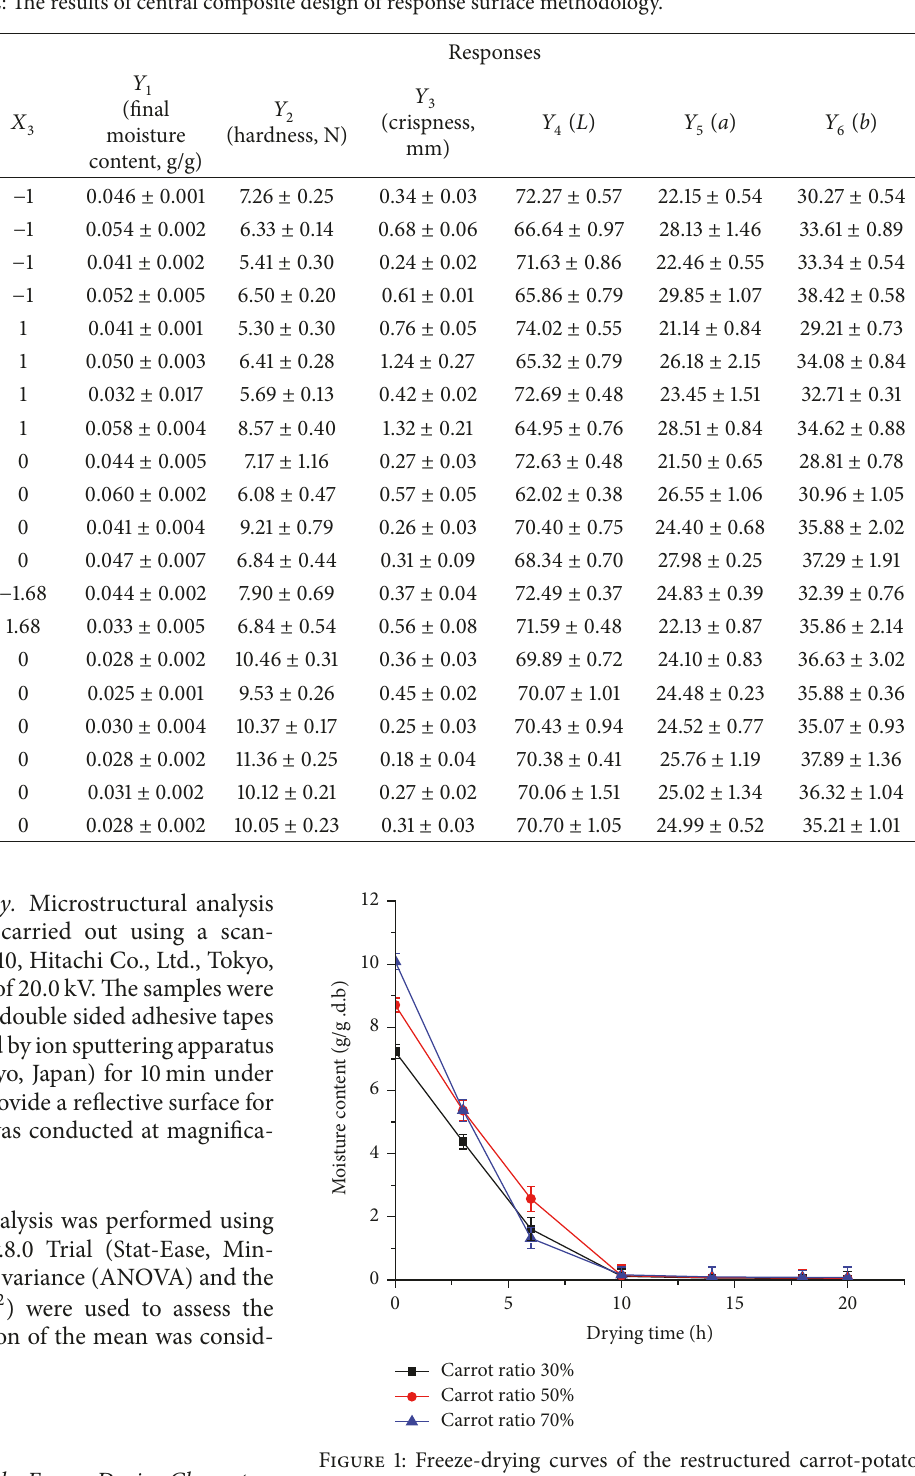
Table 2: The results of central composite design of response surface methodology.